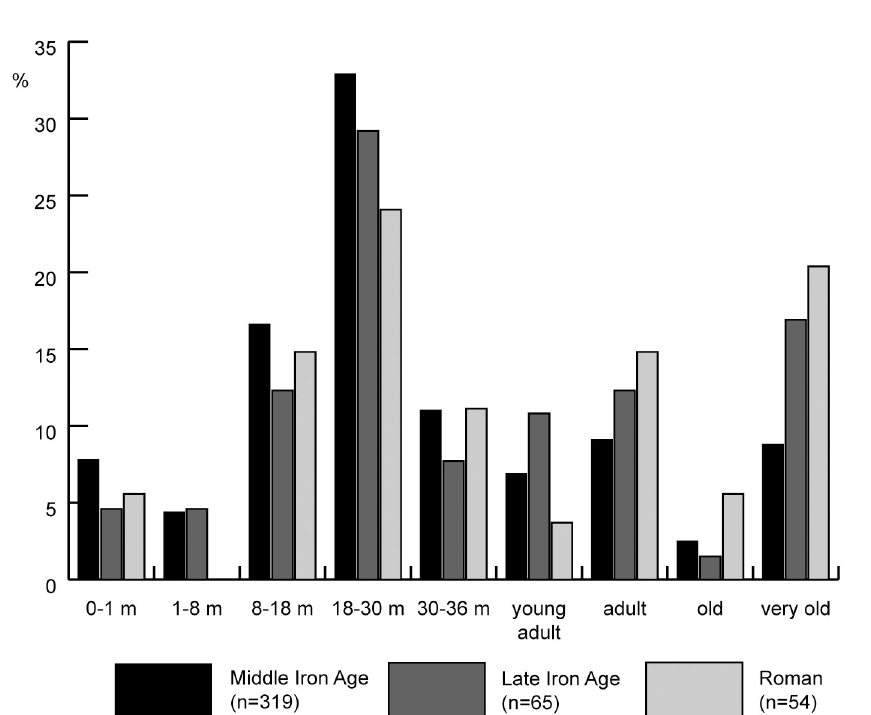
Fig 3. Mortality profile for cattle from Houten-Castellum, based on mandibular tooth eruption and wear.